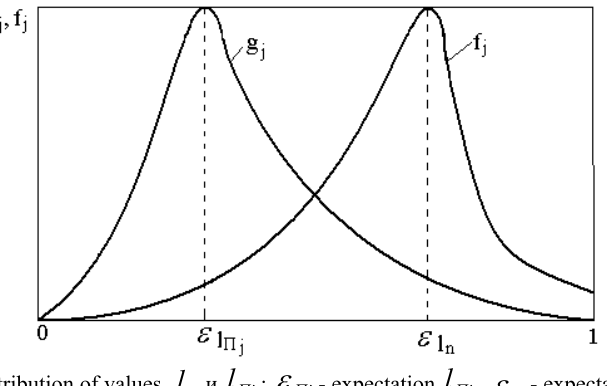
Fig. 1. Density distribution of values